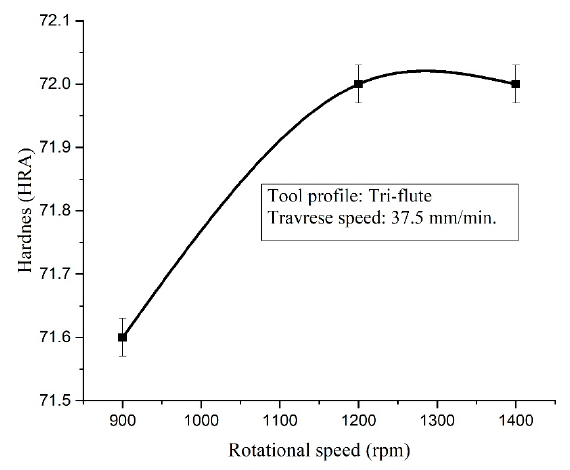
Figure 13. Influence of rotational speed on hardness strength.